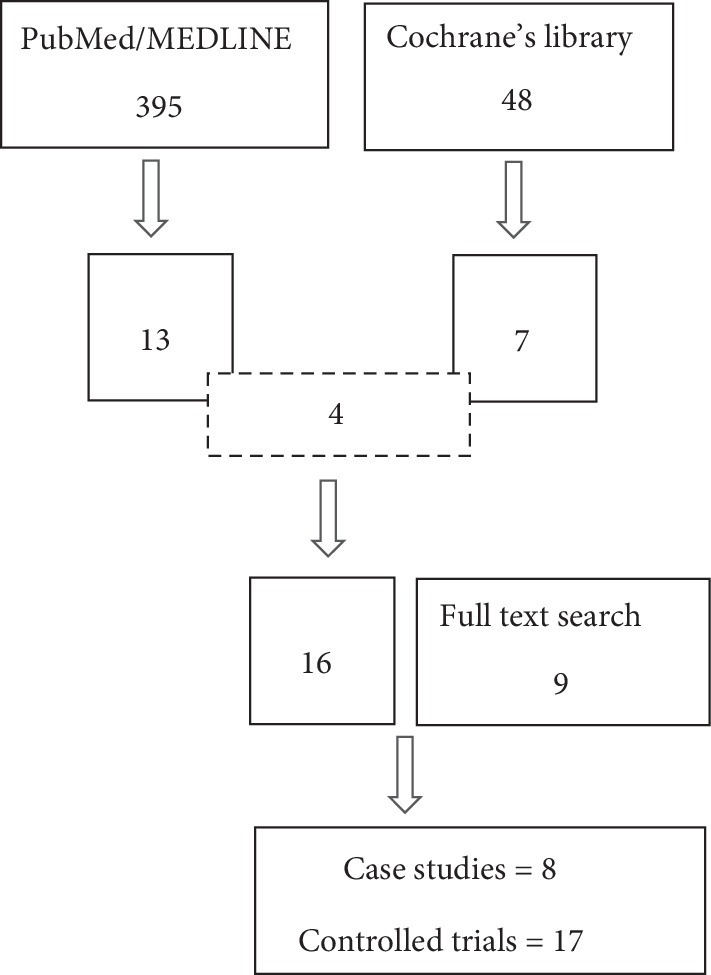
Literature search result.